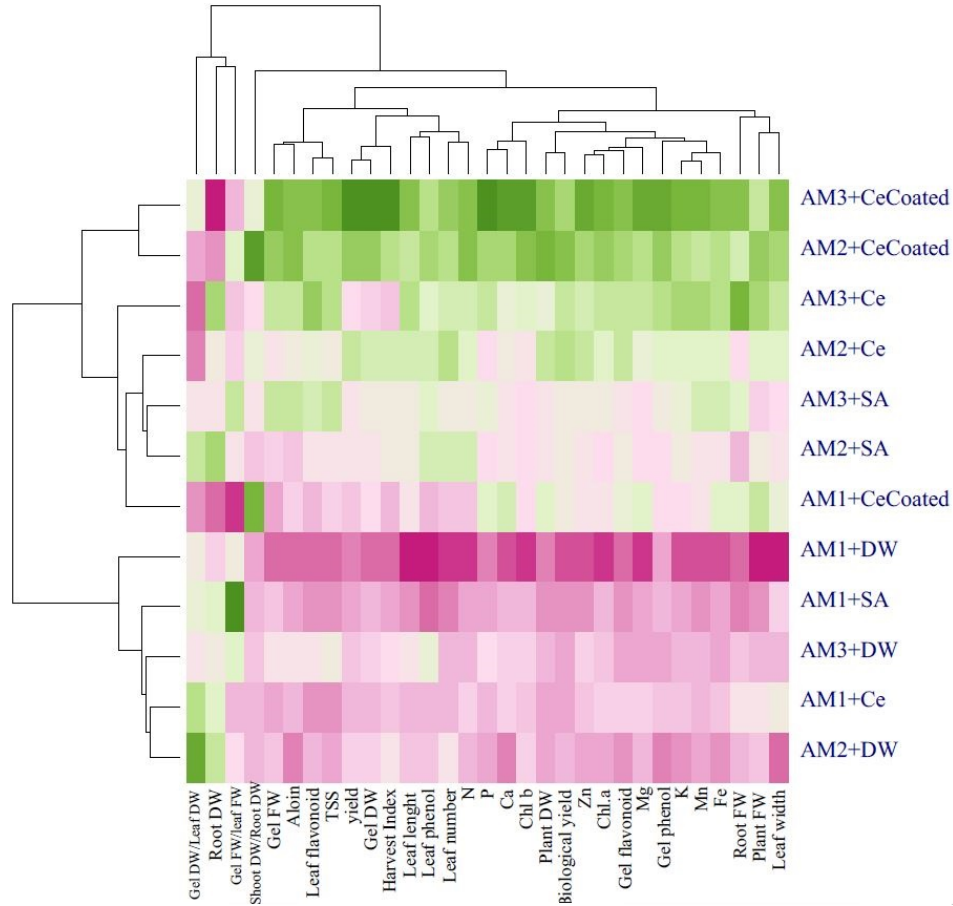
Figure 8. Heat map of cluster analysis dendrogram for the effects of soil-based animal manure use and foliar application (distilled water, salicylic acid, cerium oxide nanoparticles, and CeO 2 :SA-nanoparticles) on the growth, physiological responses, and elemental content of Aloe vera L. plants. FW and DW refer to fresh and dry weight, respectively. AM1 = without animal manure), AM2 = 10% animal manure, and AM3 = 20% animal manure. SA is salicylic acid), Ce is cerium oxide nanoparticles, and CeCoated is CeO 2 : SA-nanoparticles. The green color and the purple color show the positive and the negative response of the evaluated traits to the treatments, respectively. Moreover, the darker green indicates more positive response, and the darker purple indicates more negative responses.